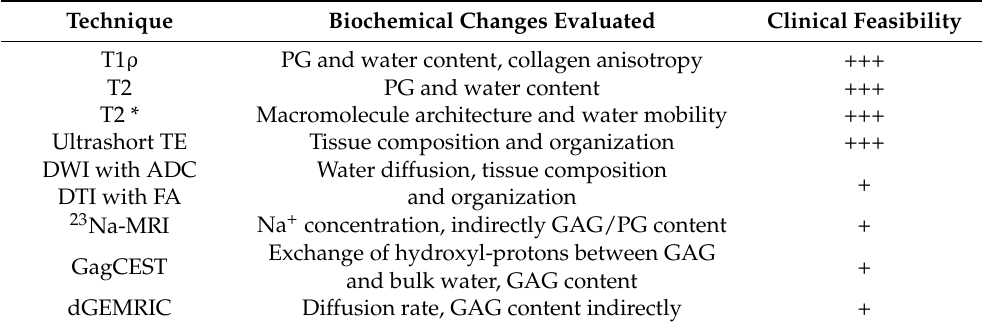
Table 1. Summary table of novel MRI techniques reported and their clinical